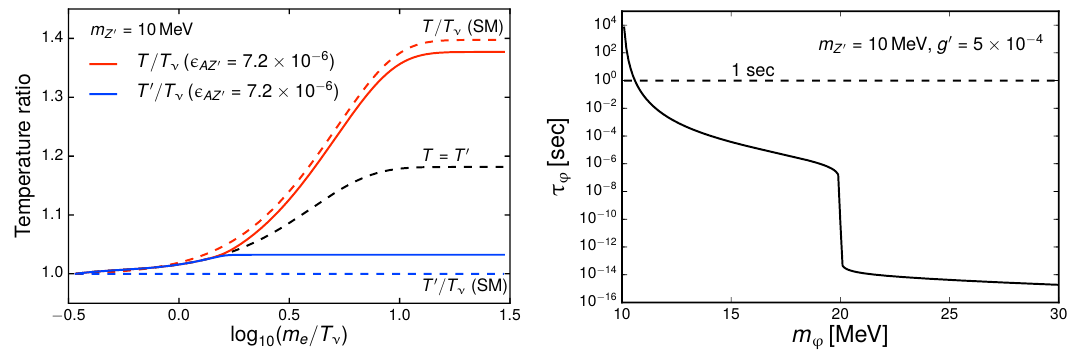
=T (cid:23) (blue) for (cid:15) AZ 0 = 7 : 2 0